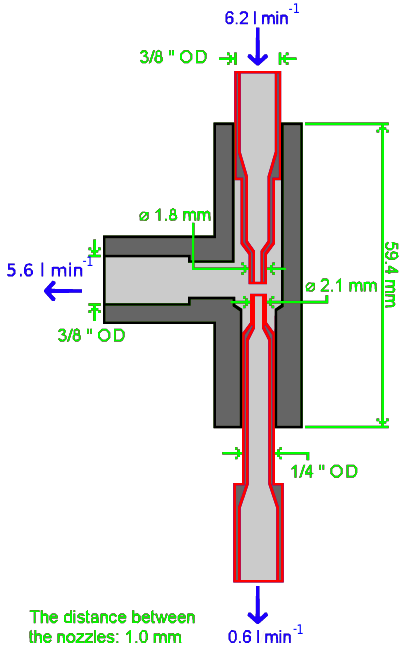
Figure A1. Schematics of the virtual impactor attached to the test setup. OD stands for outside diameter. The red pipes are enclosed by the black outer case. A more detailed figure is available on request.